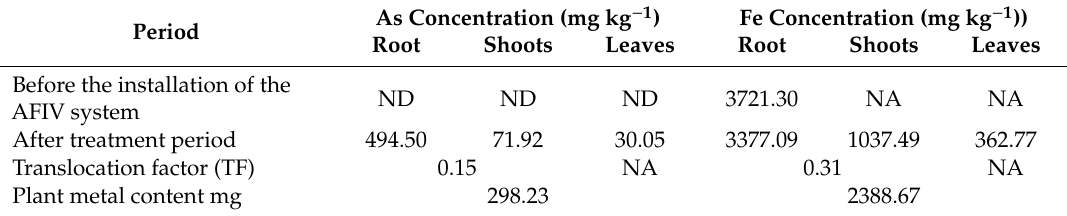
Table 1. Estimation of heavy metal contents in shoot, root, and leaves of Vetiver in As and Fe contaminated water before and after the installation of the AFIV